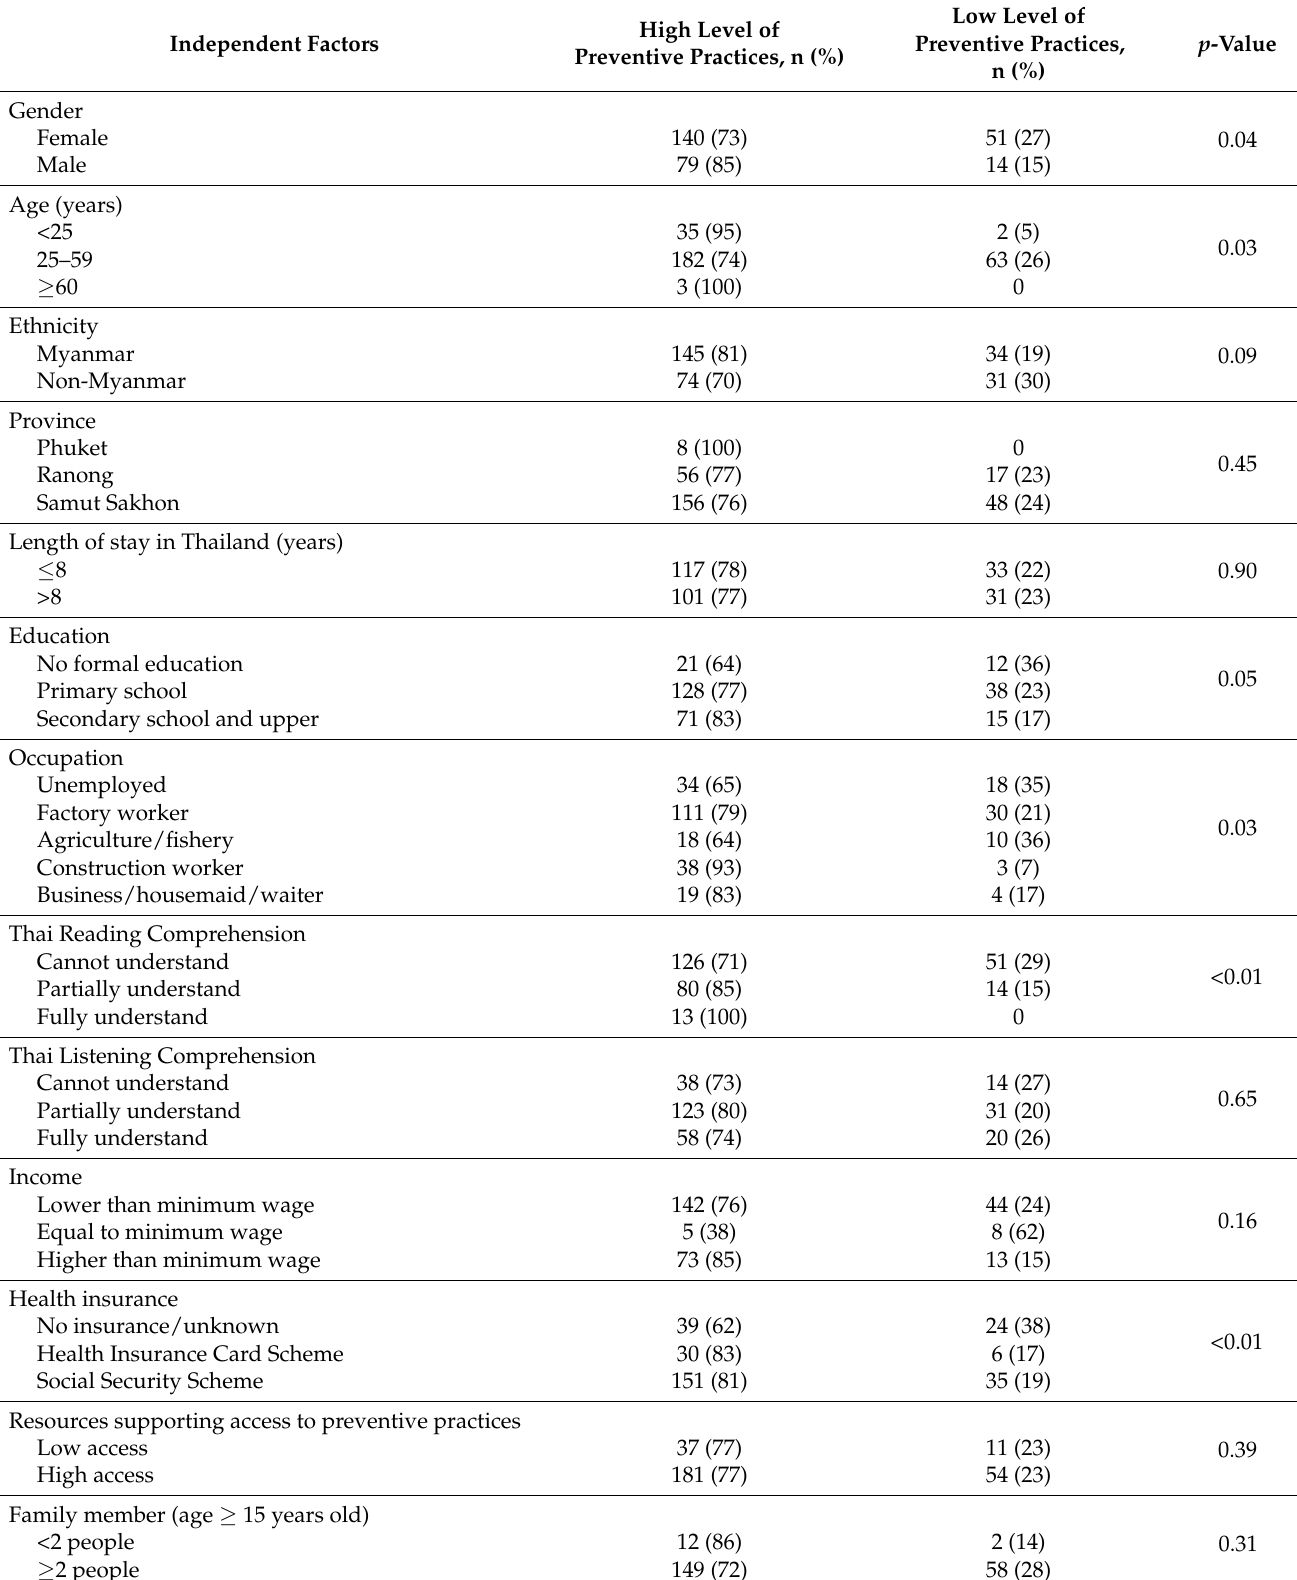
Table 4. Univariate analysis on self-reported preventive practices during COVID-19.